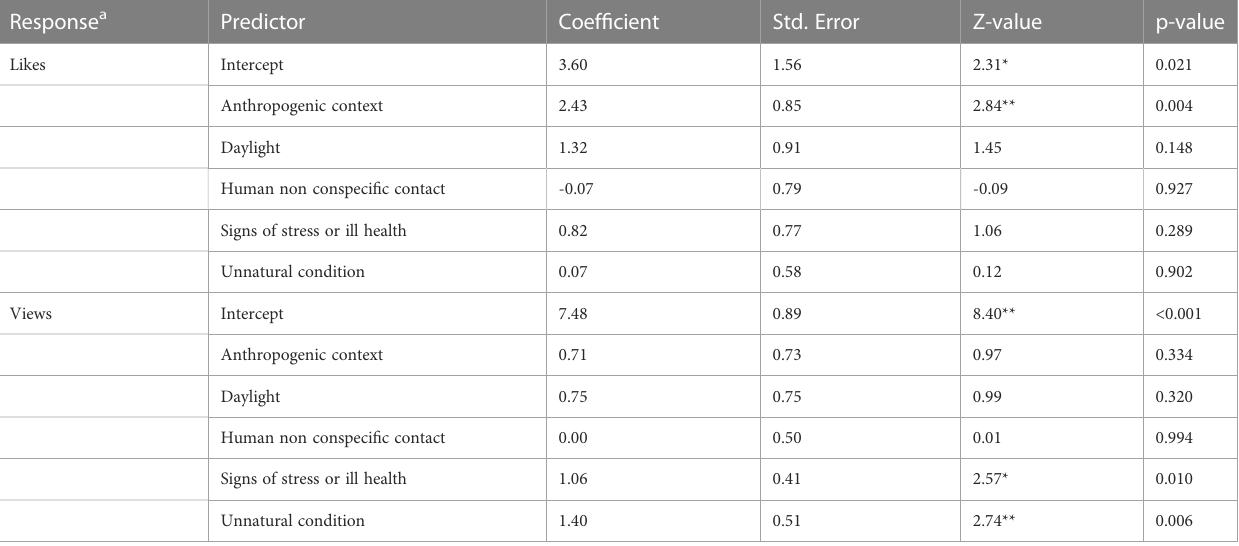
TABLE 2 Results of the Generalised Linear Models to understand the in fl uence of each parameter used to calculate the decontextualization score on the number of likes and views on TikTok and YouTube videos. Reference categories for predictors: “ Yes ” . Response